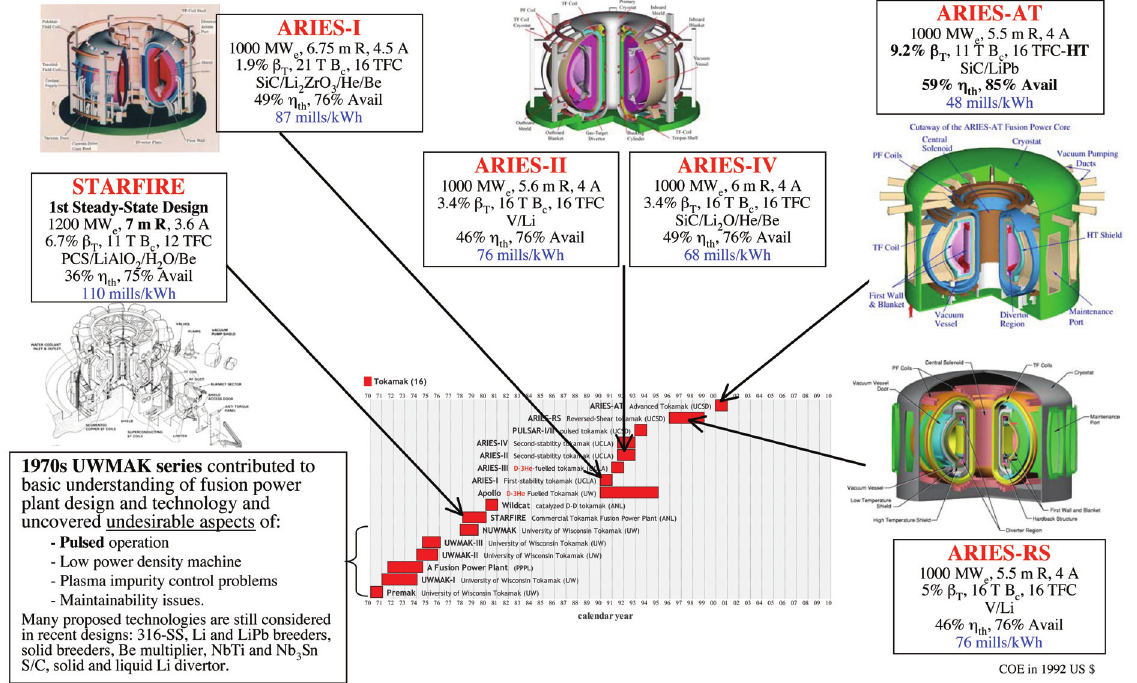
Figure 2. Timeline and main features of US tokamak power plant studies.